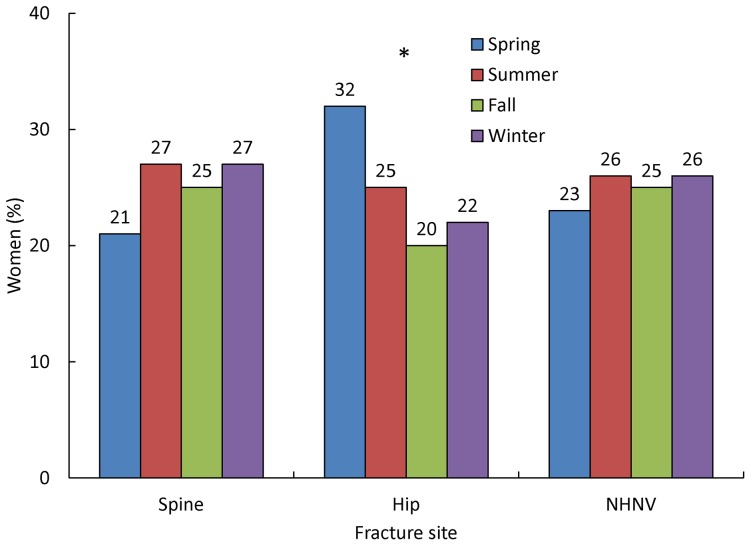
Seasonal variation of fracture rates according to fracture site.Significant differences for each season within fracture types (P<0.05) are denoted by an asterisk. NHNV, non-hip, non-vertebral.